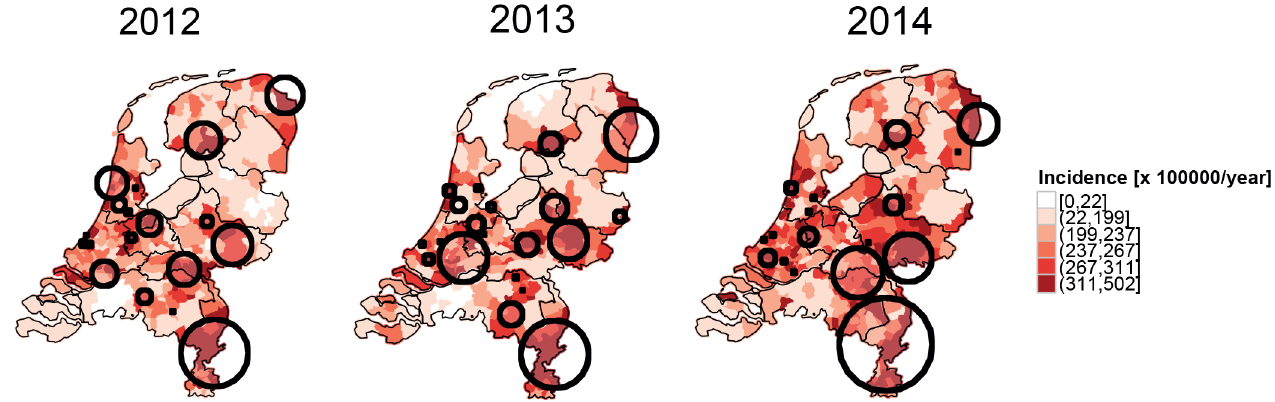
Fig 2. Maps of incidence of unspecified pneumonia cases at municipality level for the years2012, 2013 and 2014. Black circles represent significantclusters (p < 0.05)identifiedwhilst imposinga 10% upper limit and choosinga non-overlappingcriterion. The incidenceintervalsin the colorbarrepresentthe quantilesof the pneumoniaincidencein